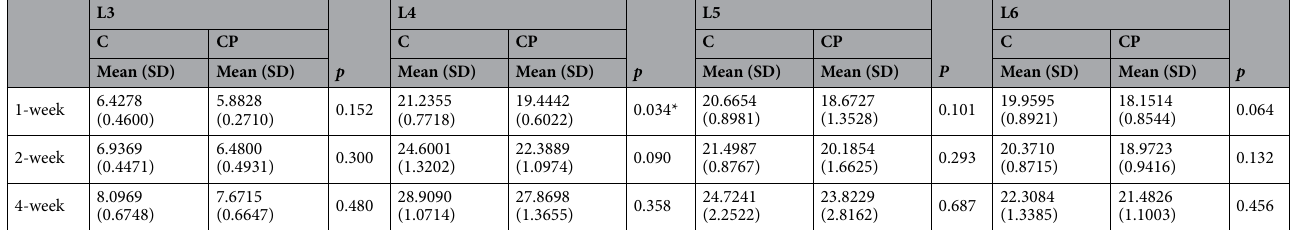
Table 5. Statistical values for length and height measurements of the mandible using computed tomography three-dimensional reconstructions. Mean values, standard deviation (SD), and p values of each distance index are shown for each group ( C control group; CP cleft palate group) at each time point in development. * p < 0.05. Mandibular length: L3 (B–P); Mandibular height: L5 (B–C), L6